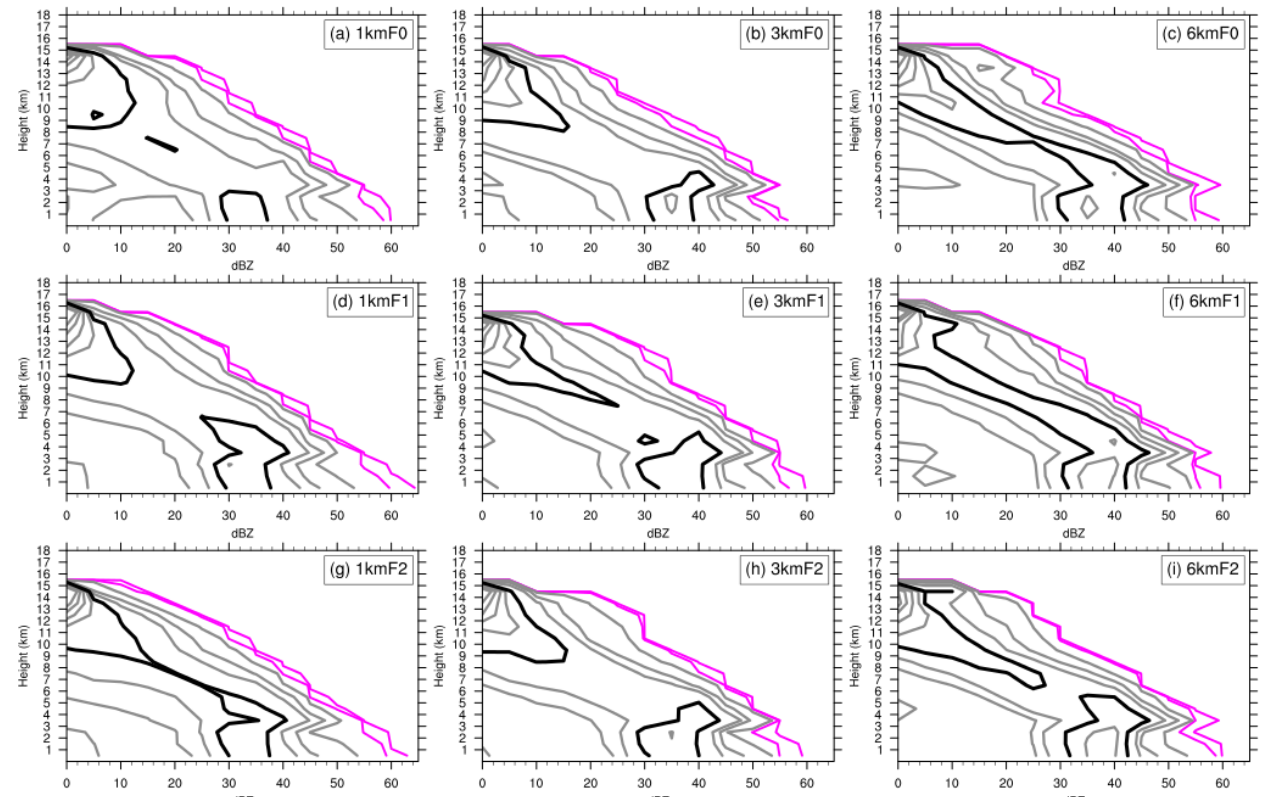
Figure 14. The same as Fig. 13 but for CFADs of simulated reflectivity with